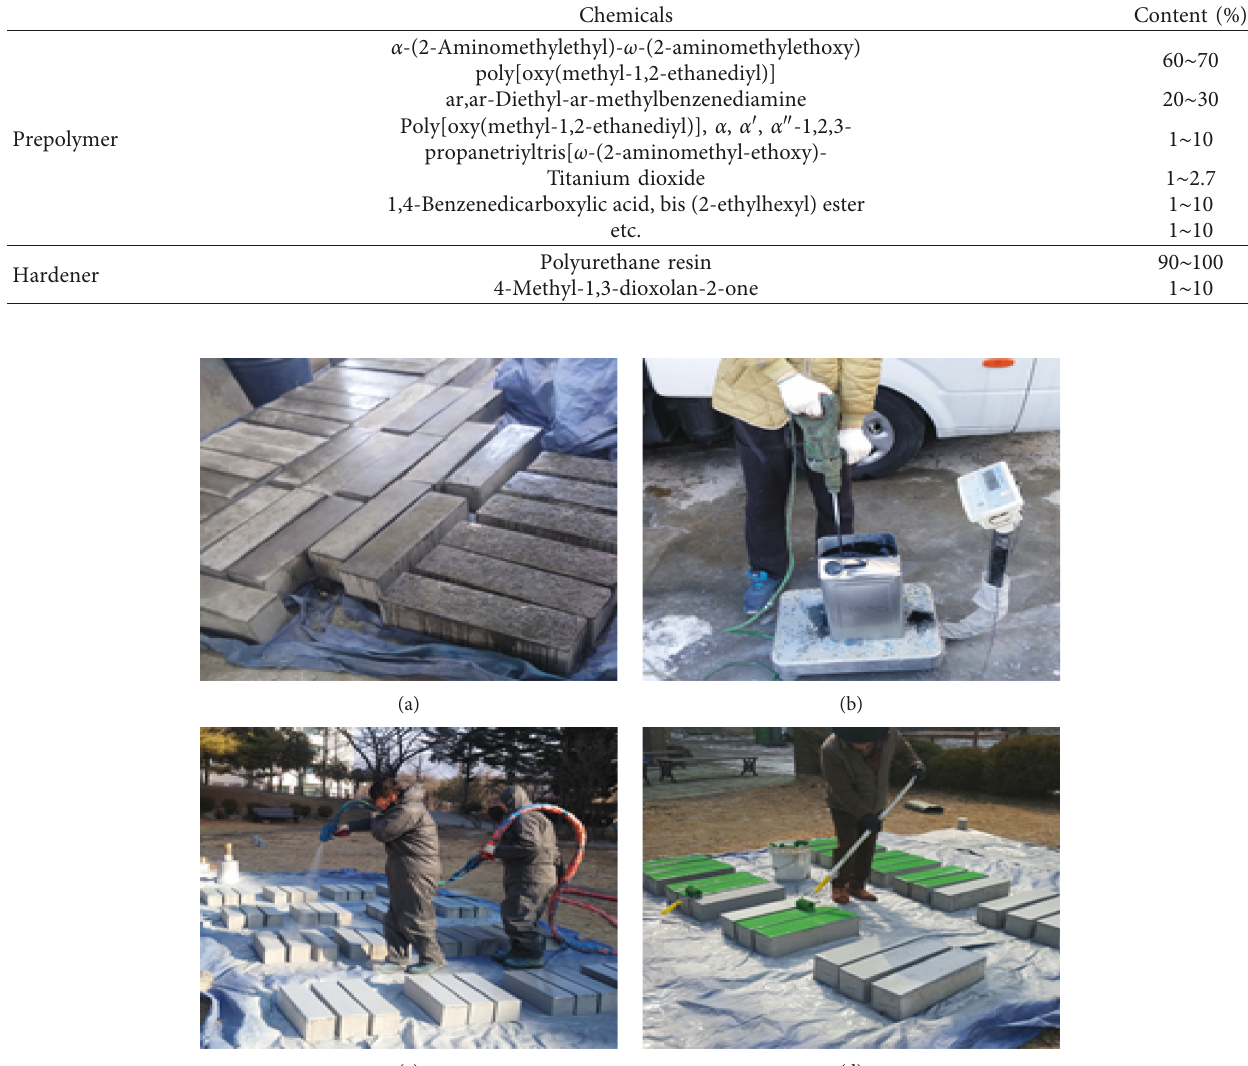
Table 1: Chemical constituents of polyurea.